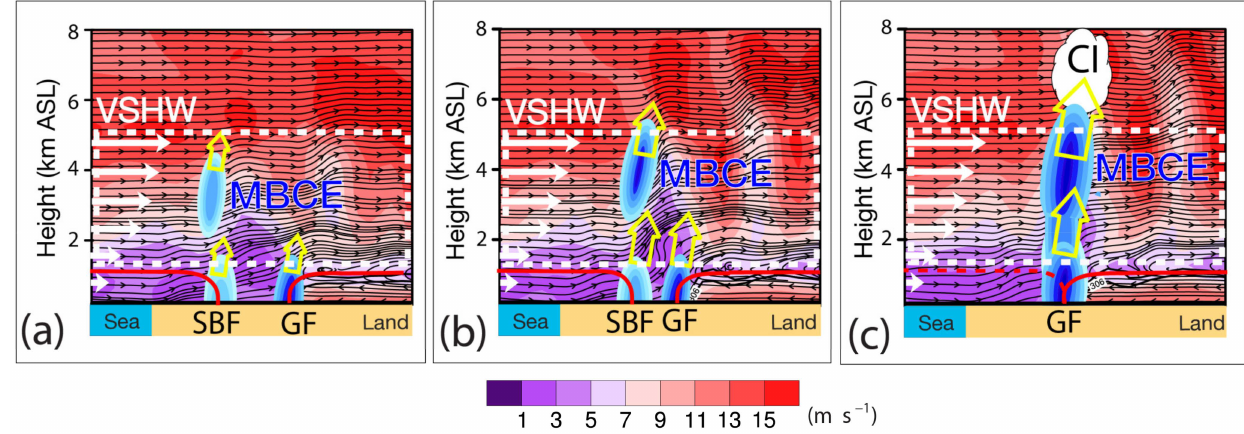
Figure 16. Schematic model summarizing CI mechanism affected by the mid-level blocking conver- gence effect (MBCE) and vertical shear of the horizontal wind (VSHW), which are considered the important dynamic force associated with the merger of the sea-breeze front (SBF) and the gust front (GF) investigated in the present study. ( a – c ) indicate the different status of the merger process. The background shading indicates the horizontal wind velocity (unit: m s − 1 ). The blue-filled ellipses denote the convergence (including the convergent leading edges of the SBF and GF, as well as the mid-level convergence due to the MBCE). The white arrows indicate the horizontal wind velocity, and the dashed white box indicates the area where there are high VSHW which is responsible for the vertical twisting. The hollow arrows in yellow indicate the updraft induced by the convergence